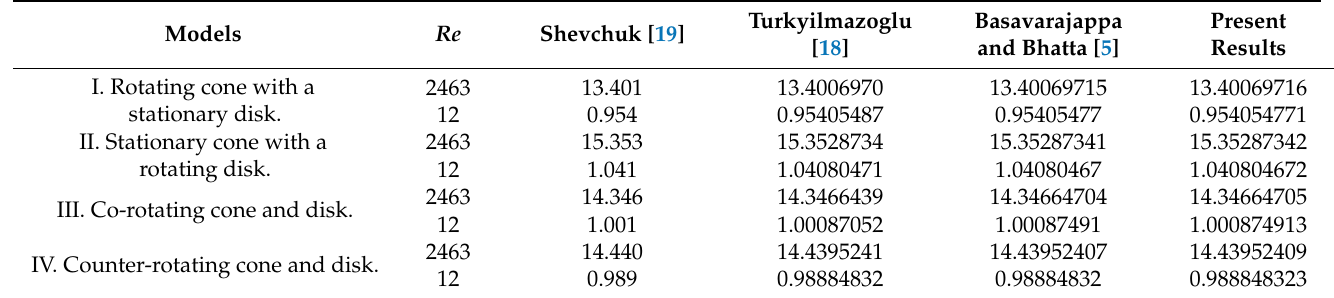
Table 1. Comparison of the current study’s coefficient of heat transfer rate when R = 0.